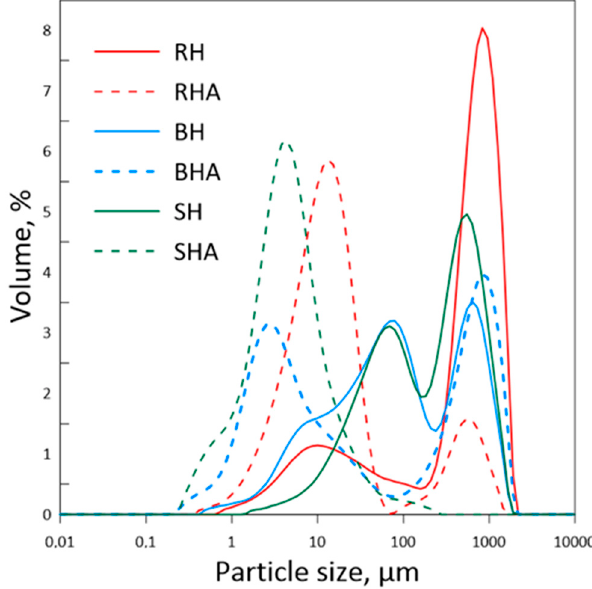
Figure 4. Particle size distribution of the fillers.